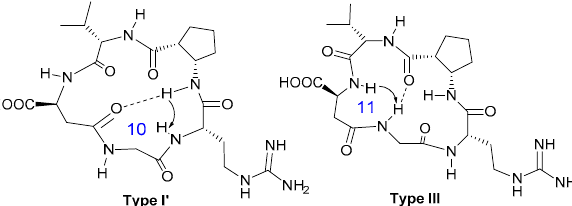
Figure 4. Preferred intramolecular H-bond / β -turn patterns proposed for the iso DGR cyclopeptide 10 spectroscopic data. The arrows indicate significant NOE contacts. Type I’ H-bonding pattern, Gly-Arg β -turn motif. Type III H-bonding pattern, Val- iso Asp pseudo β -turn motif.